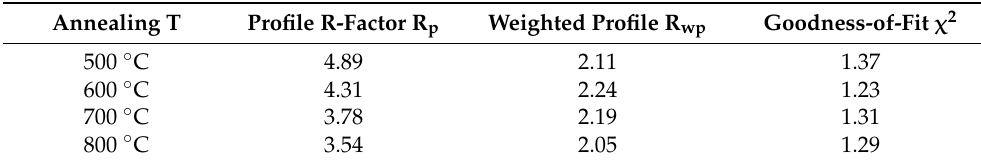
Figure 6. Mössbauer spectra of the Fe 65 Pt 15 Zr 3 B 17 samples, annealed at 500 ◦ C, 600 ◦ C and 700 ◦ C together with the fitted subspectra. Table 2. The obtained R-factors, as resulted from the full-profile refinement XRD patterns of annealed samples. Profile Rp, weighted profile Rwp and goodness-of-fit χ 2 are shown.